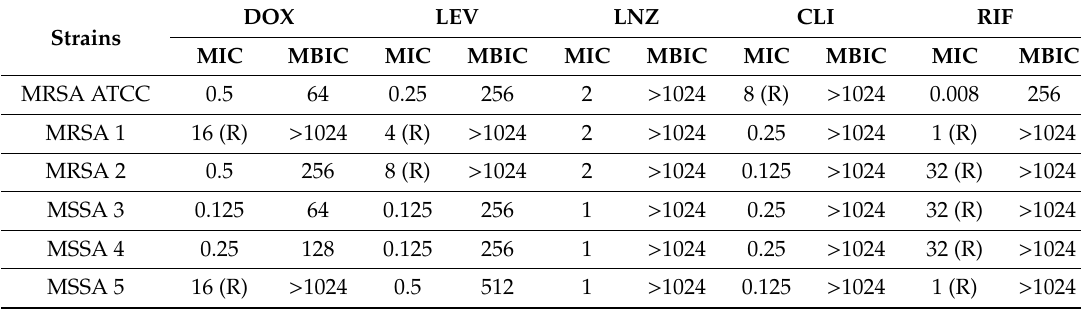
Table 1. MIC and MBIC values ( µ g / mL) for the antibiotics tested against rifampin-resistant S. aureus